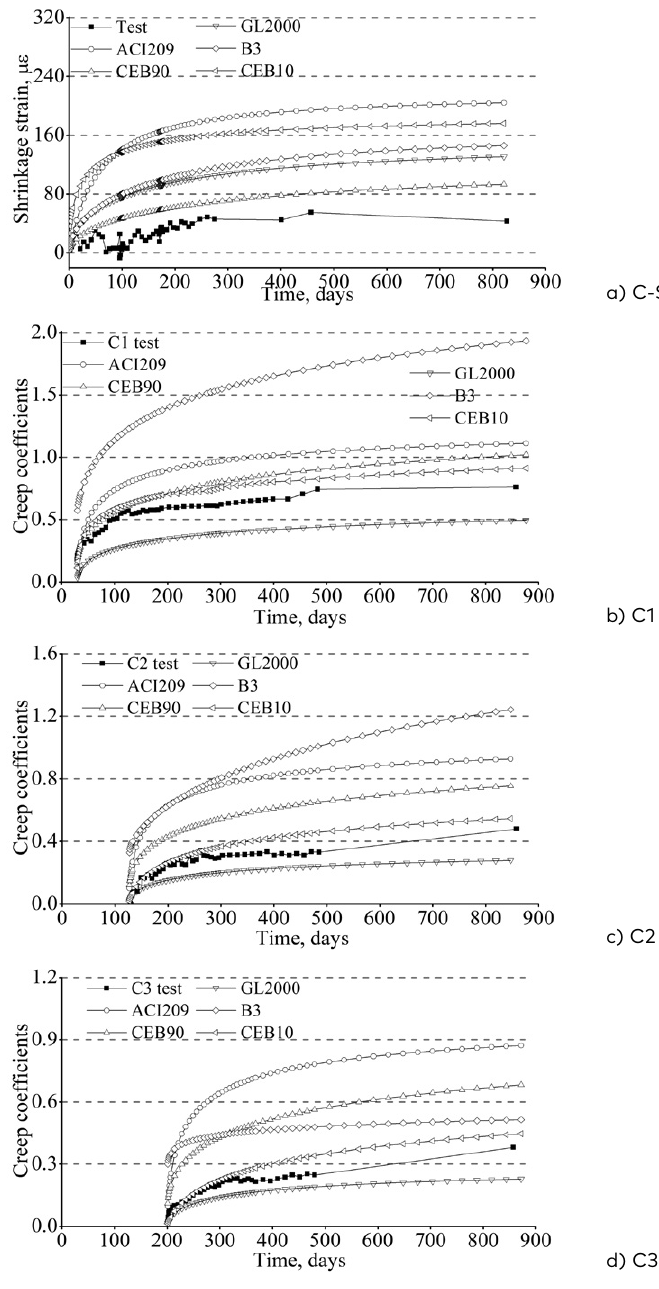
Figure 9. Comparison of experimental and predicted results for C80